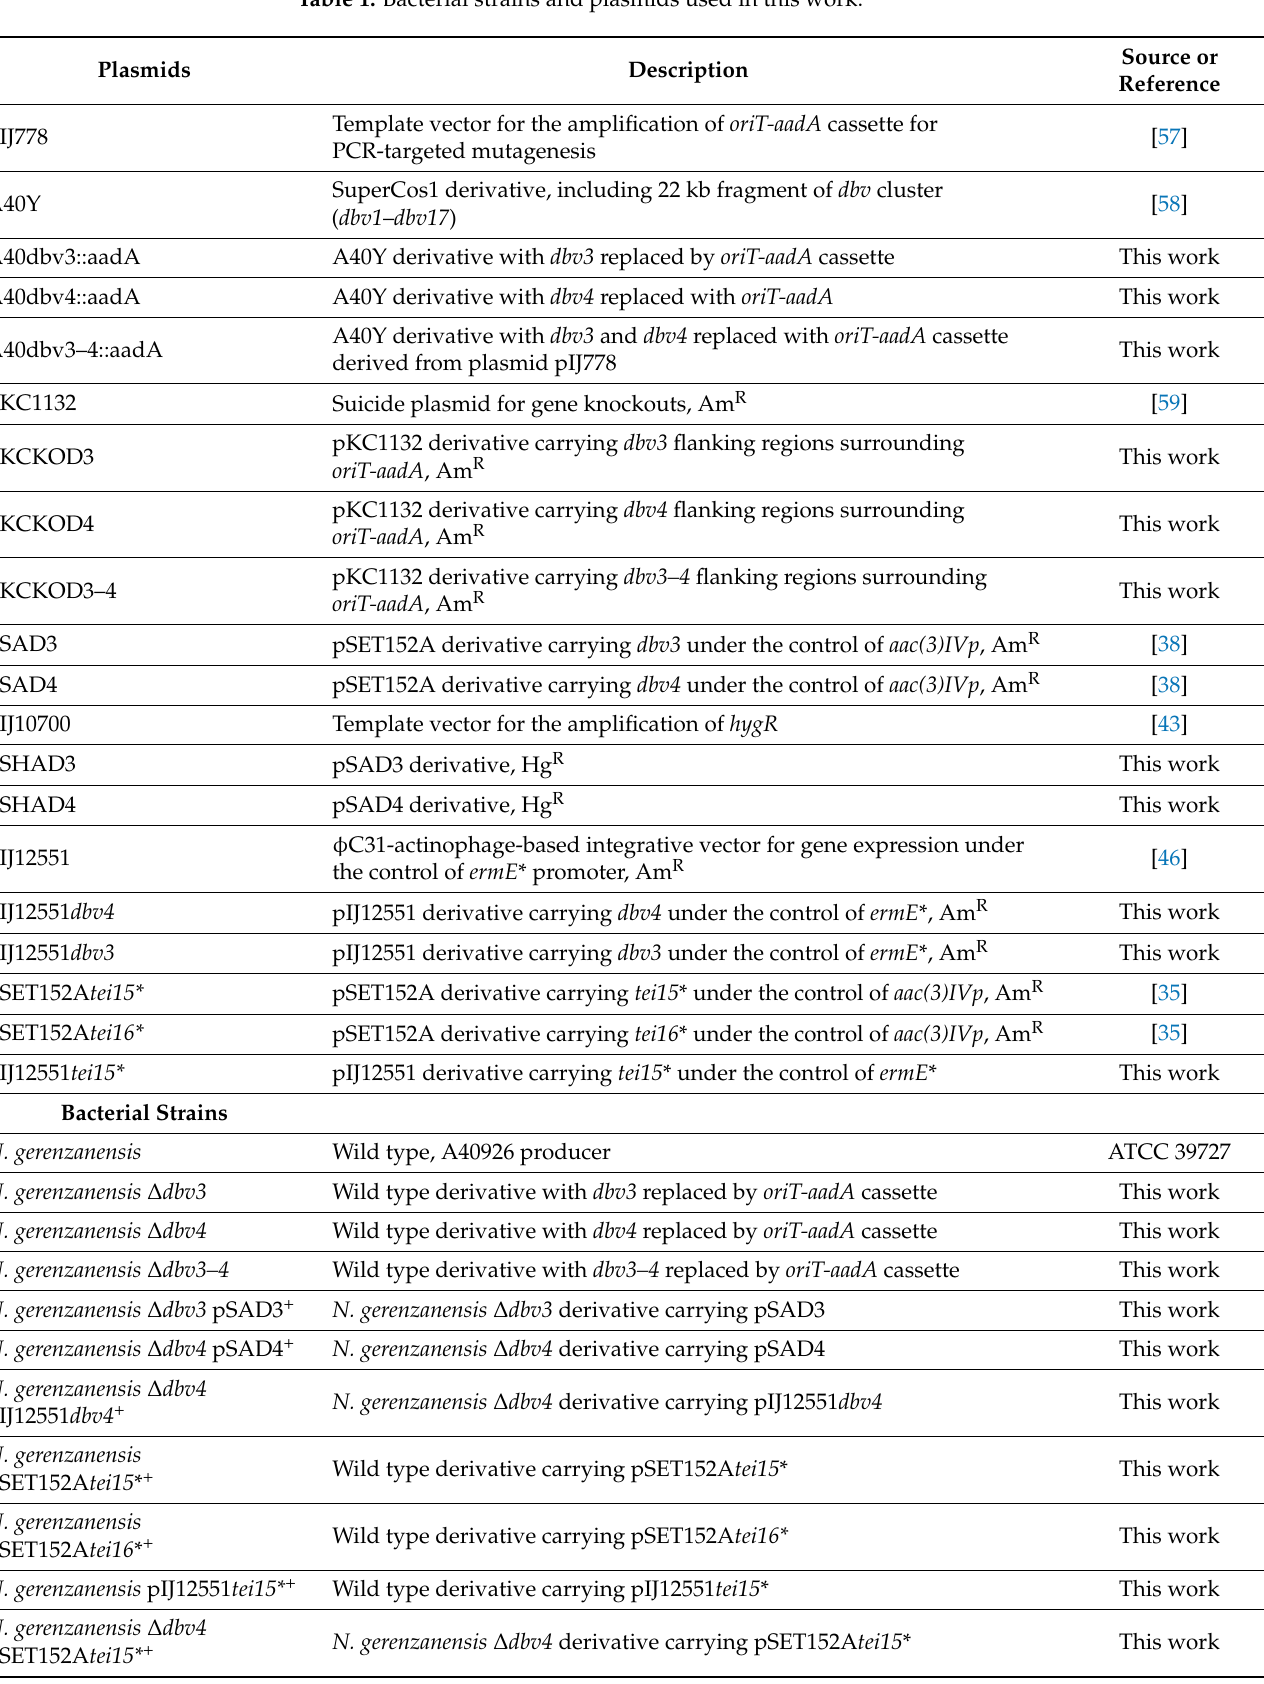
Table 1. Bacterial strains and plasmids used in this